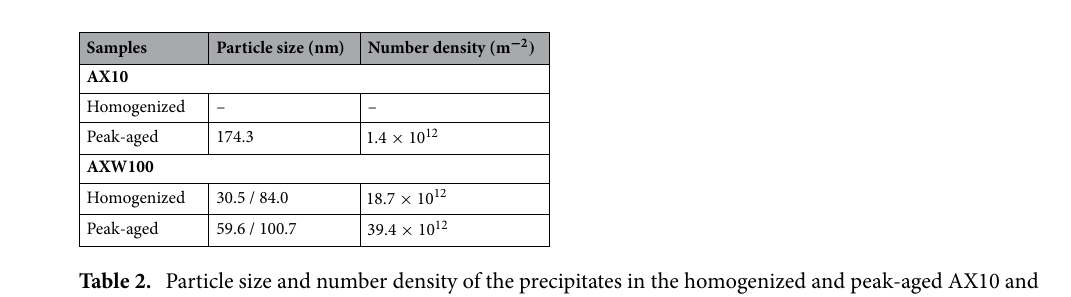
Figure 4. TEM images of ( a ) the homogenized and ( d ) peak-aged AX10 alloy sheets. High-magnified STEM images and corresponding EDS maps of ( b , c ) the homogenized and ( e , f ) peak-aged AX10 alloy sheets for Mg, Al and Ca. The arrows in ( a ) indicate the contrast in vicinity of grain boundaries. The circles in ( b , c ) correspond to a C36 particle consisted of Mg, Al and Ca and the arrow in ( e , f ) indicates an inhomogeneous distribution of alloying elements in a particle.